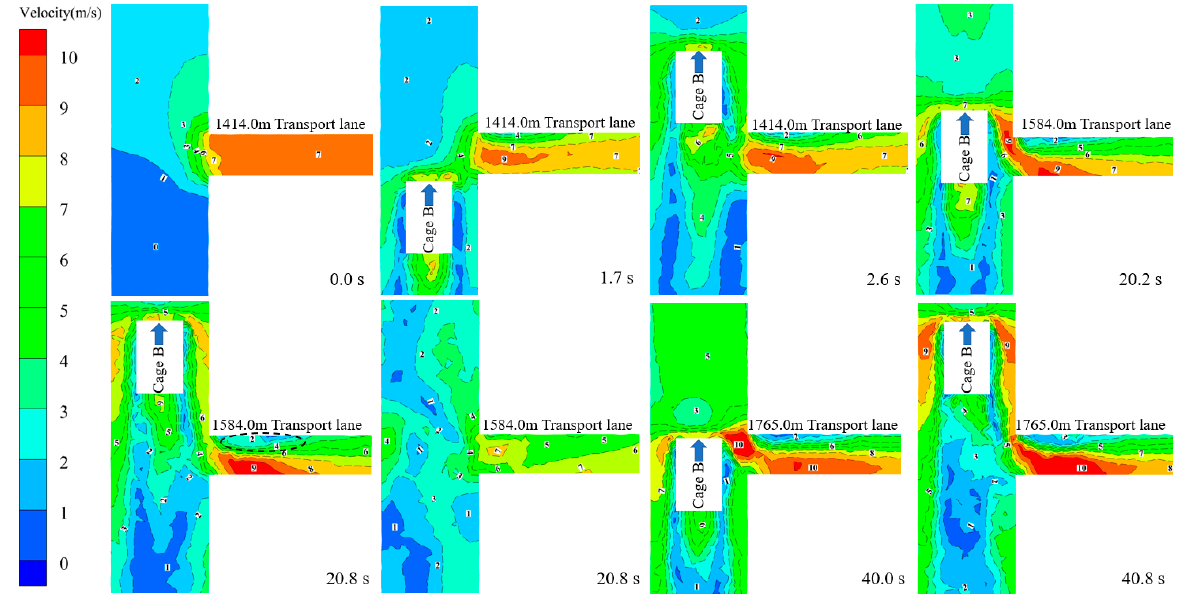
Figure 7. Velocity field distribution of each transport lane in x = − 1 m section.